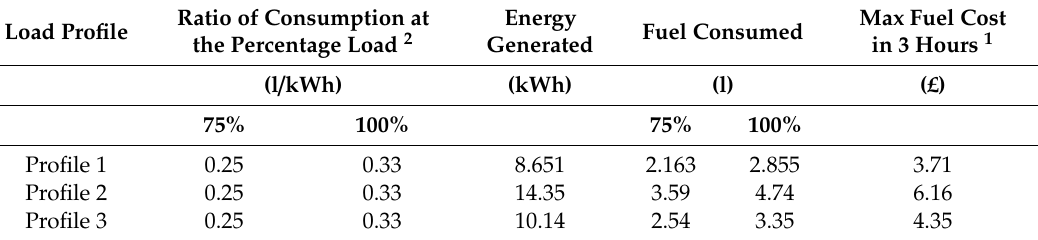
Table 3. Diesel generator fuel consumption—stand alone and without